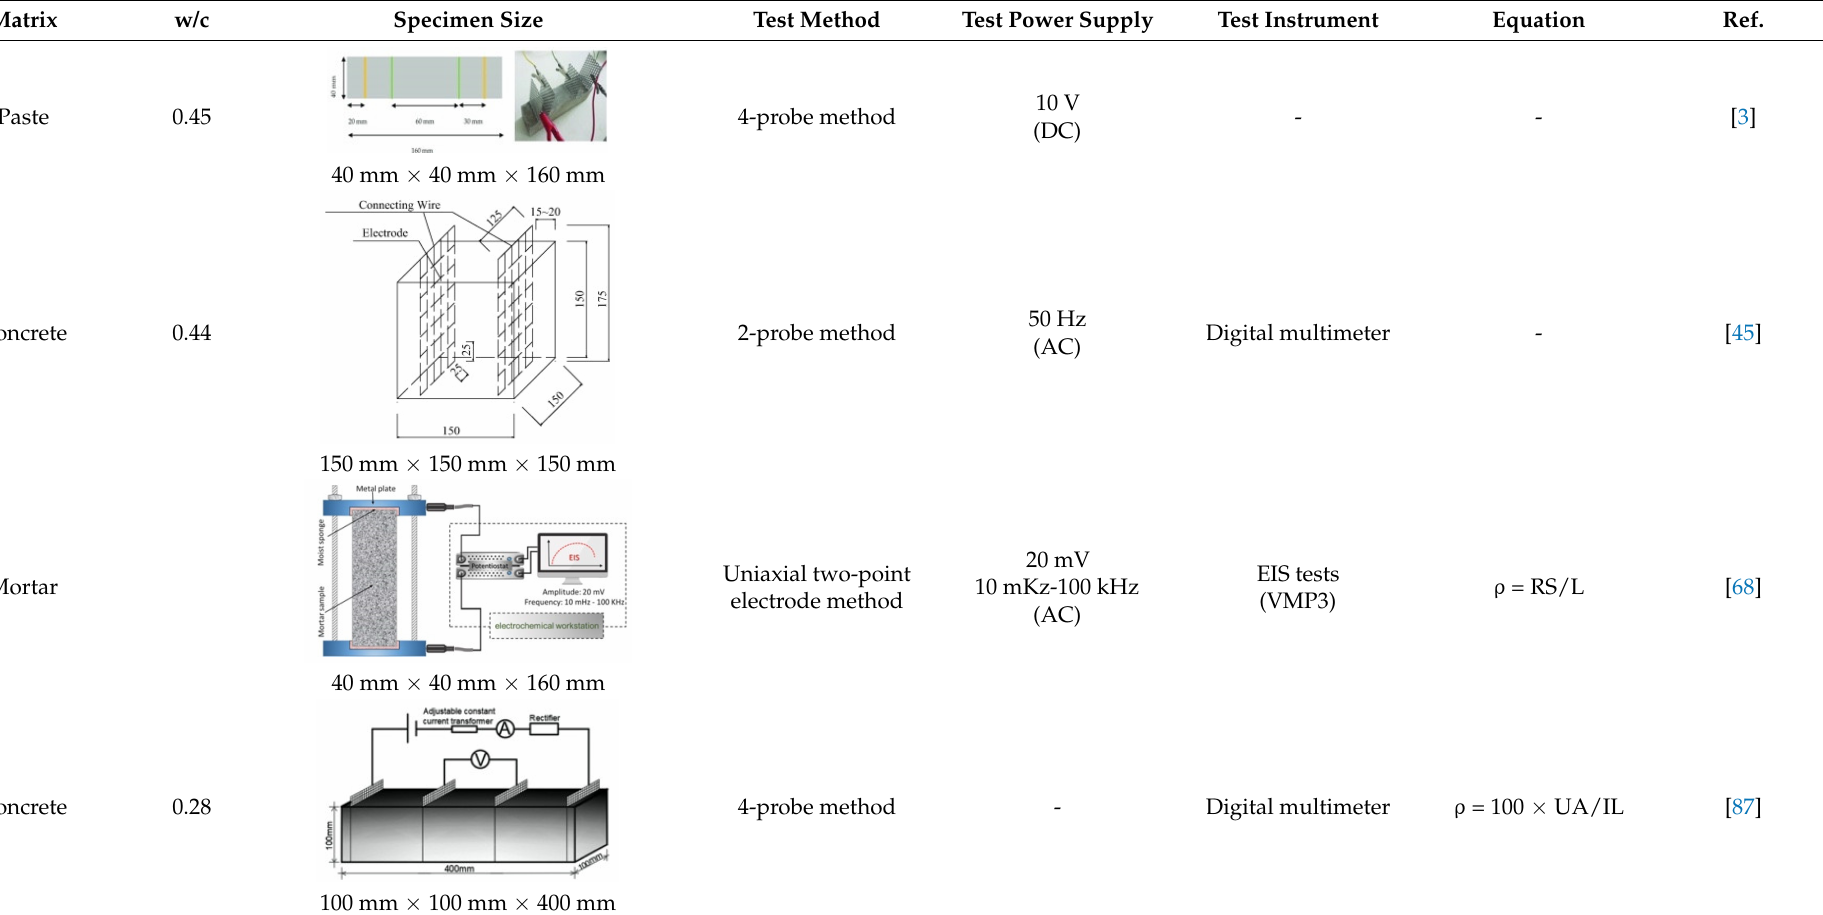
Table 4. Electrical resistivity measurement